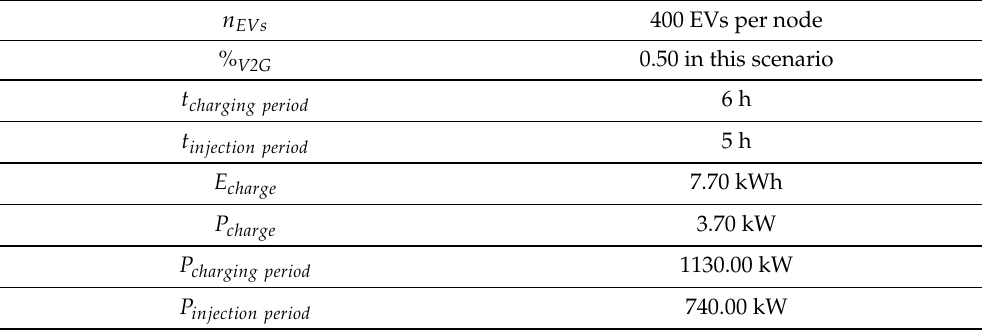
Table 2. EV scenario with 50% V2G connection (calculations for each